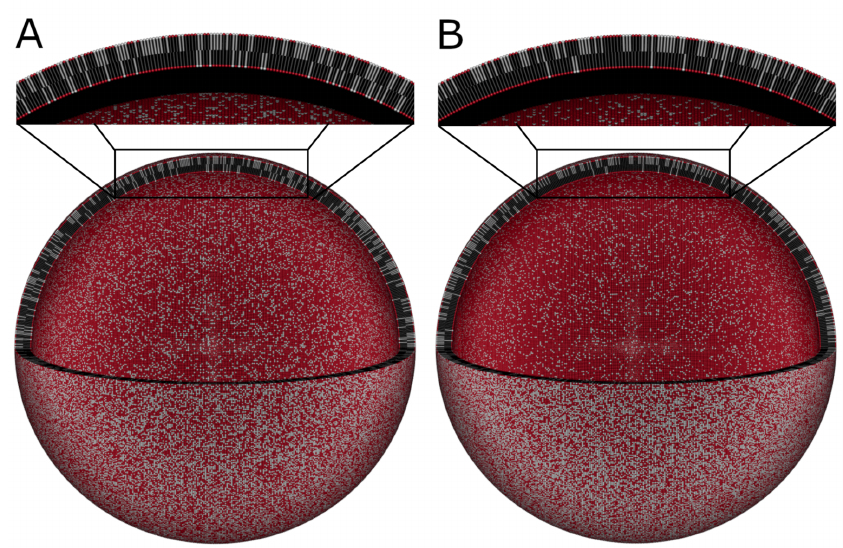
Figure 8. Schematic of the use of SANS with contrast variation and selective deuteration to determine how charged lipids respond to the peptide melittin [101]. DMPC:DMPS vesicles prepared at a molar ratio of 7:3 with and without the peptide melittin are shown with a wedge removed so that the inner leaflet of the bilayer can be seen. A zoomed-in view is also provided. ( A ) When no peptide is present, the outer leaflet of the bilayer is enhanced in charged lipids (the light structures) relative to neutral lipids (red and black structures). ( B ) When melittin is added at a peptide-to-lipid ratio of 1/200, further enhancement of the charged lipid content of the outer leaflet of the bilayer can be seen. The images in the figure used the results of the study in reference [101] and were created using the software developed for the table of contents graphic of the reference and the POV-Ray software version 3.7 [193]. The figure has not been published